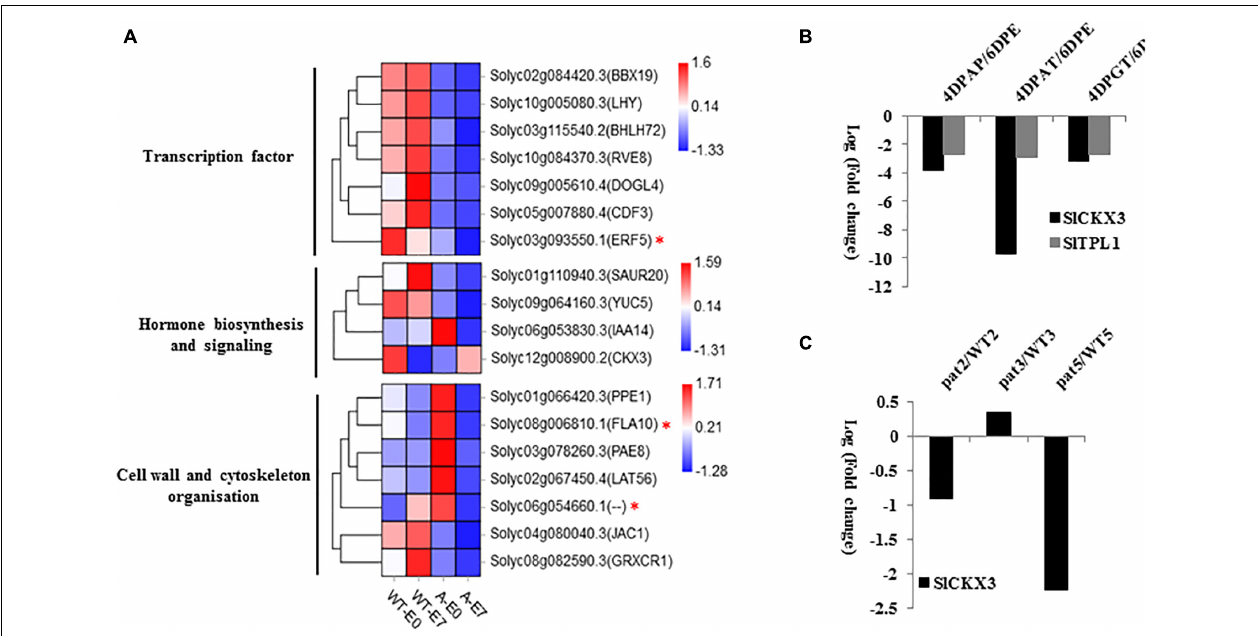
FIGURE 8 | (A) Heatmap of DEGs in the gene set comprising 118 genes involved in hormone biosynthesis and signaling pathways, transcription factor, cell wall and cytoskeleton organization, and other genes involved in the fruit set process; (B) The expression data of SlCKX3 and SlTPL1 in tomato ovaries after artificial, auxin and GA triggered fruit set. 6DPE: 6 days post emasculation. 4DPAP: 4 days post artificial pollination. 4DPAT: 4 days post auxin treatment. 4DPGT: 4 days post gibberellin treatment. (C) The expression data of SlCKX3 in pat ovaries. pat2: pat ovaries at 2 days before anthesis stage; pat3: pat ovaries at 0 days post anthesis stage. pat5: pat ovaries at 2 days post anthesis stage. WT2: wild type ovaries at 2 days before anthesis stage; pat3: wild type ovaries at 0 days post anthesis stage. WT5: wild type ovaries 2 days post anthesis